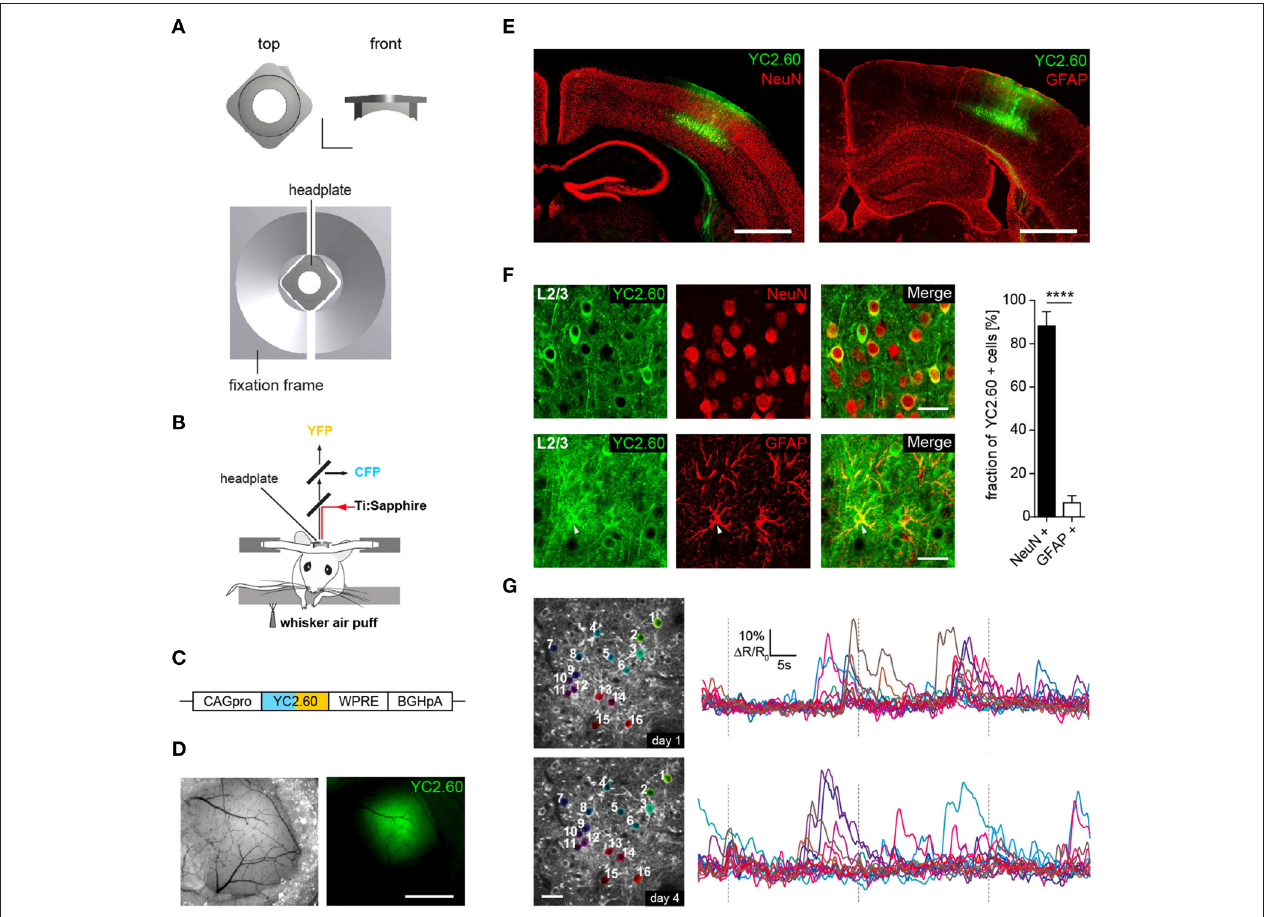
FIGURE 1 | Chronic in vivo two-photon activity imaging. (A, Top) Titanium head-plate in rectangular design is shown with a top and a front view. Scale bar: 5 mm. (Bottom) Headplate in the corresponding fixation device. (B) Schematics for experimental setup for two-photon Ca 2 + imaging of neural activity evoked by sensory stimulation. Sensory stimulation was achieved through an air-puff to the mystacial whiskers on the right side. (C) YC2.60 is expressed under control of the CAG promoter (CAGpro) and delivered into the barrel cortex by rAAV injection. WPRE, woodchuck-hepatitis posttranscriptional regulatory element; BGHpA, bovine growth hormone polyadenylation signal. (D) Wide-field images showing superficial blood vessels used for orientation and virus injected region within the barrel cortex. Scale bar: 1mm. (E) Fluorescence images of brain slices from animals that were used for 2P-imaging show YC2.60 fluorescence in cortical layers. Note the absence of gliosis in the virus-injected region. Scale bar: 1mm. (F, Left) Example images for immunofluorescence analysis for co-expression of YC2.60 and NeuN or GFAP in layer 2/3. Arrow indicates YC2.60-expressing glial cell. Scale bar: 30 µ m. (Right) Quantification of co-expression of YC2.60 and NeuN or GFAP reveals strong expression tropism for neurons (90 ± 6%) over glial cells (6 ± 3%). Error bars = SEM, **** p < 10 − 6 ; unpaired Student’s t -test, n = 6 mice (600 cells in total). (G) Chronic in vivo Ca 2 + imaging in layer 2/3 of the barrel cortex. (Left) Images depict example brain region for functional imaging on day 1 and day 4 (depth = ∼ 120 µ m from the dura mater); scale bar: 25 µ m. (Right) Example activity traces from all cells for a single trial on two different imaging days are